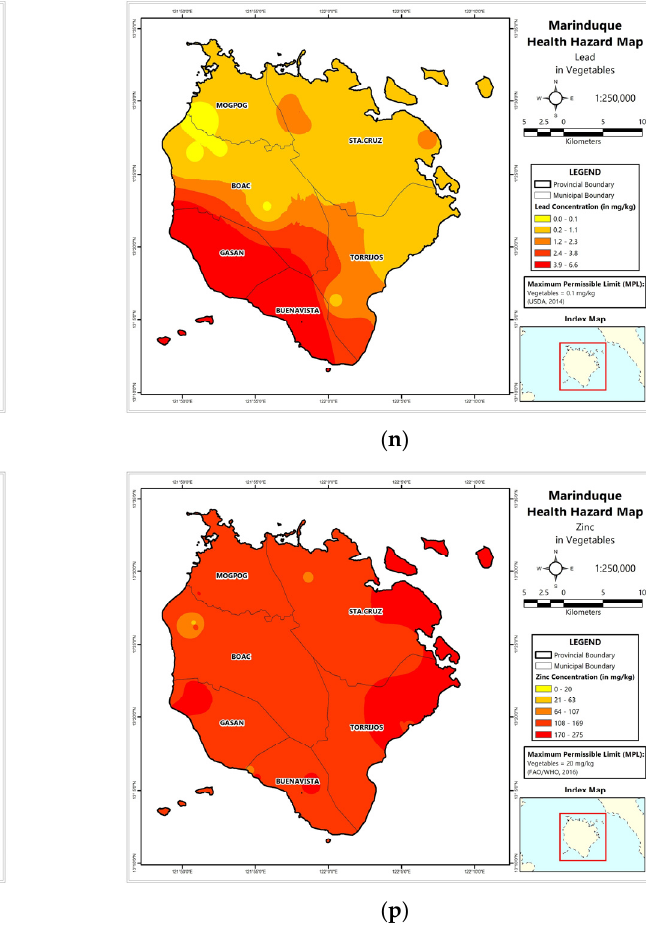
Figure A1. Spatial distribution maps of metal concentrations in soil and vegetables. ( a )